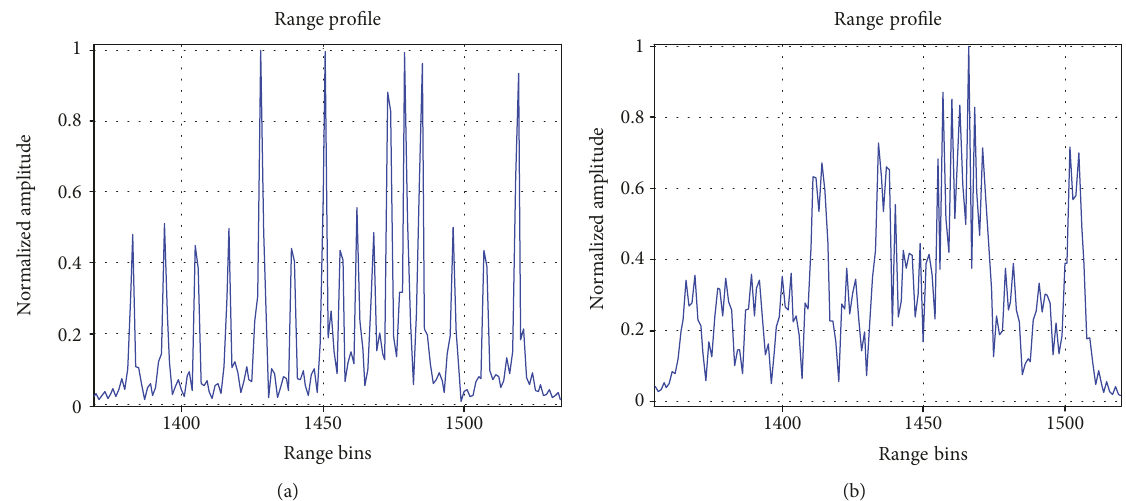
Figure 3: The output of the narrowband matched fi lter: (a) the output after pulse compression when v =200 m/s; (b) the output after pulse compression when v =2000 m/s.